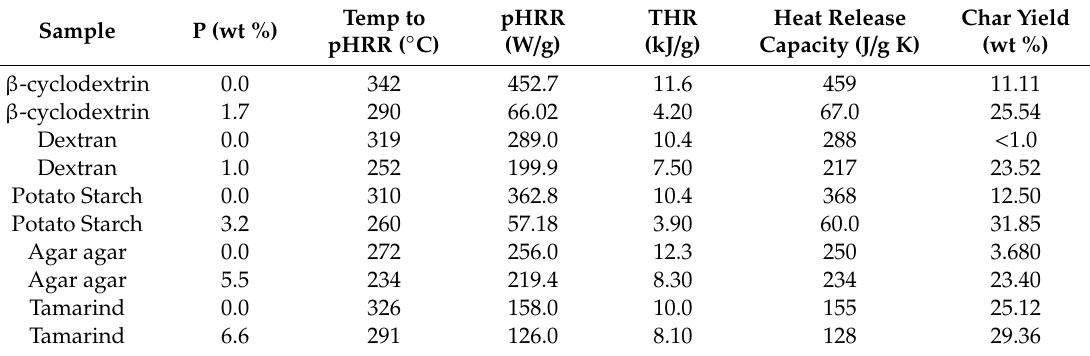
Figure 8. Plot of the heat release rate (HRR) (W/g) versus temperature (°C) for modified and unmodified versions of β -cyclodextrin.